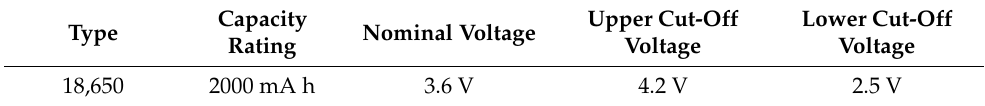
Table 1. Specifications of battery samples.